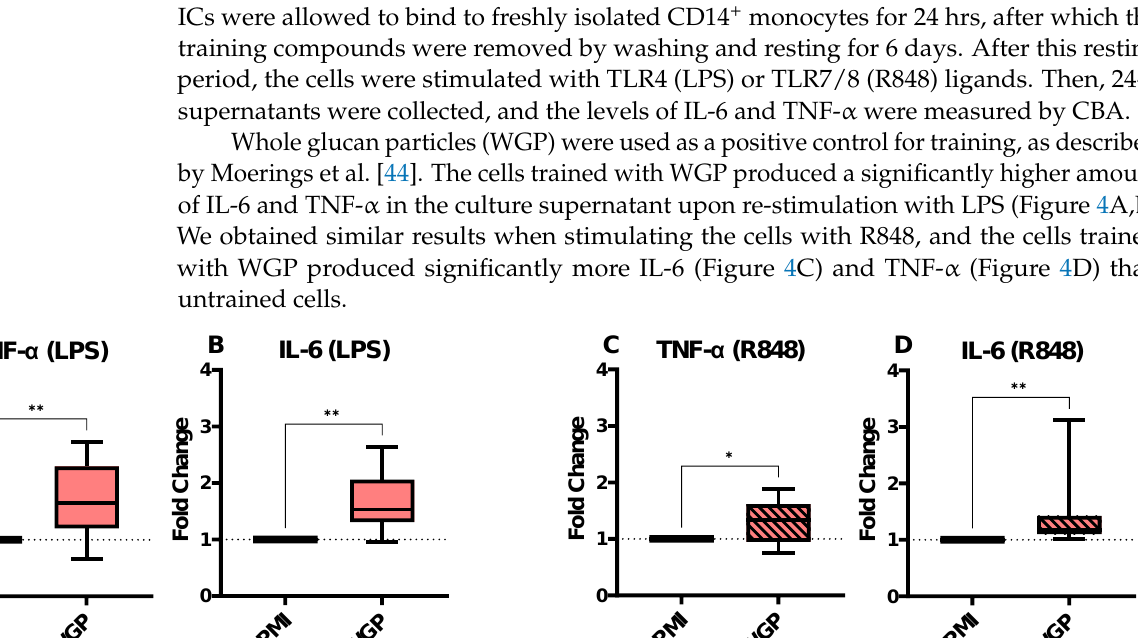
9 of 19 Figure 3. The curves drawn from MFI of the bIgG detection signal: the monocytes were exposed to bIgG only (0 – 100 µg/mL), α -bIgG (5 µg/mL) only, α -bIgG only (1 µg/mL), and the bIgG: α -bIgG ICs in one representative donor (donor A) ( A ). The delta MFI (  MFI) was produced when the MFI of the bIgG only signal was deducted from the MFI of the bIgG: α -bIgG ICs signal ( B ). 3.2. BIgG-Containing Immune Complexes and Innate Immune Training Based on the above findings, we used the optimal ratios of bovine IgG to RSV preF